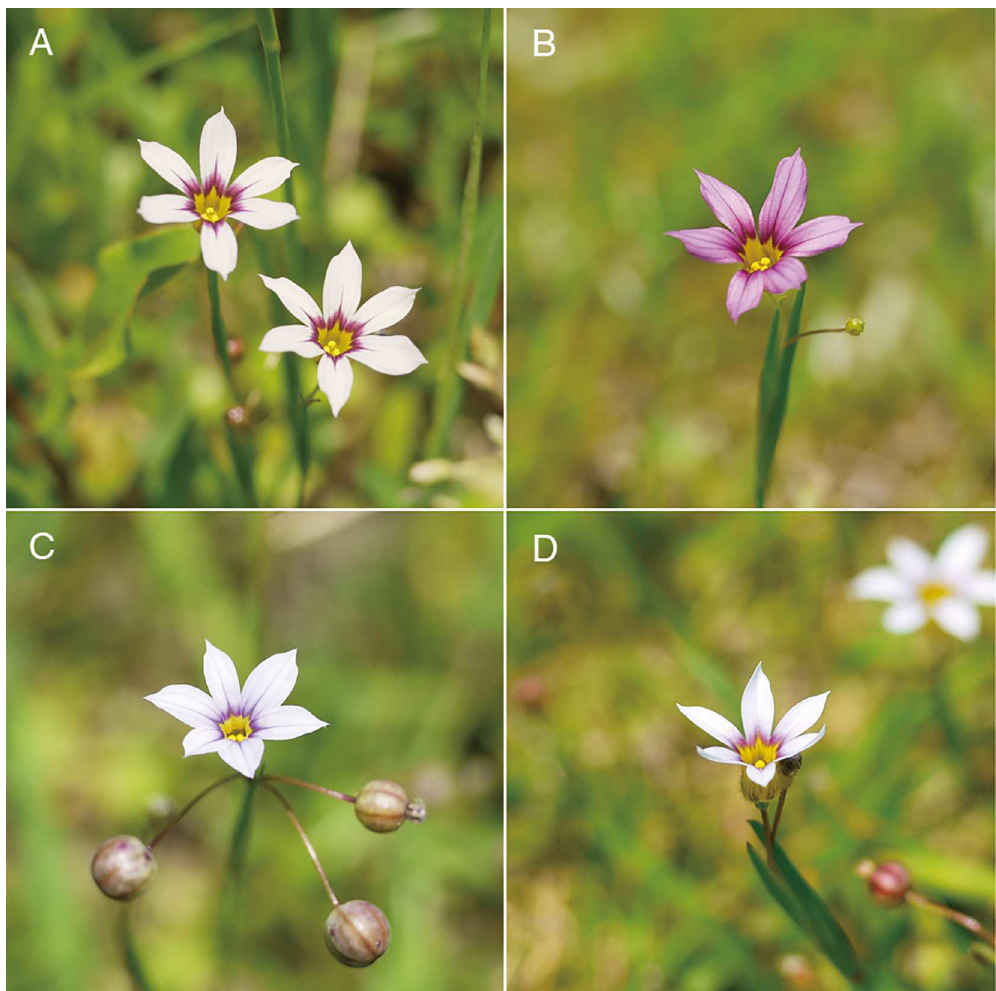
Fig 1. The three species of Sisyrinchium . The M-species exhibits two morphs consisting of a white (a) and purple morph (b). L-species (c) and S-species (d) are monomorphic (only white). L-species is taller and has bigger fruits than M- and S-species. S-species has smaller flower than that of other species. Flowers of L- and S-species are more constricted at the middle of the tepals than M-species. Photographs were taken by